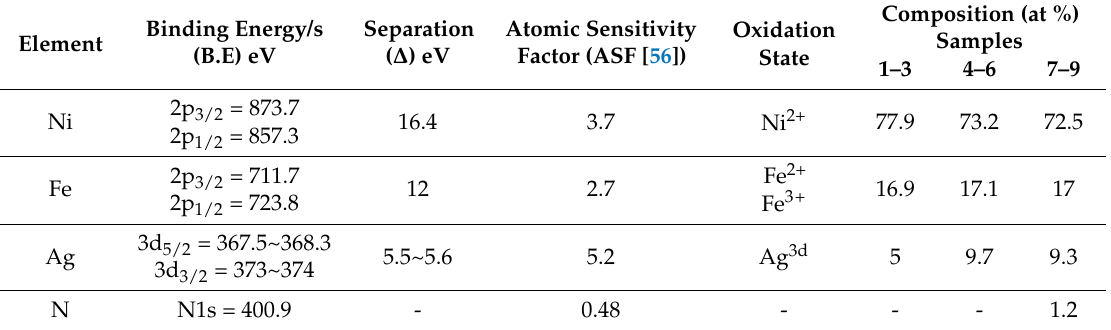
Table 2. Binding energies, separation values, atomic sensitivity factor (ASF), oxidation state, and chemical composition during